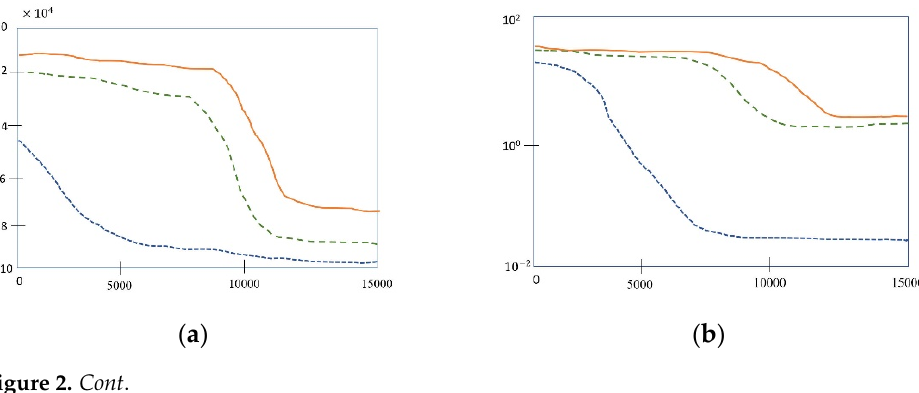
( f ) Figure 2. Comparison of dynamic performance of three DPSO algorithms in the case of 300 dimen- sions. ( a ) F 8 function, ( b ) F 10 function, ( c ) F 11 function, ( d ) F 12 function, and ( e ) F 13 function, ( f ) algo- rithm icon illustration.